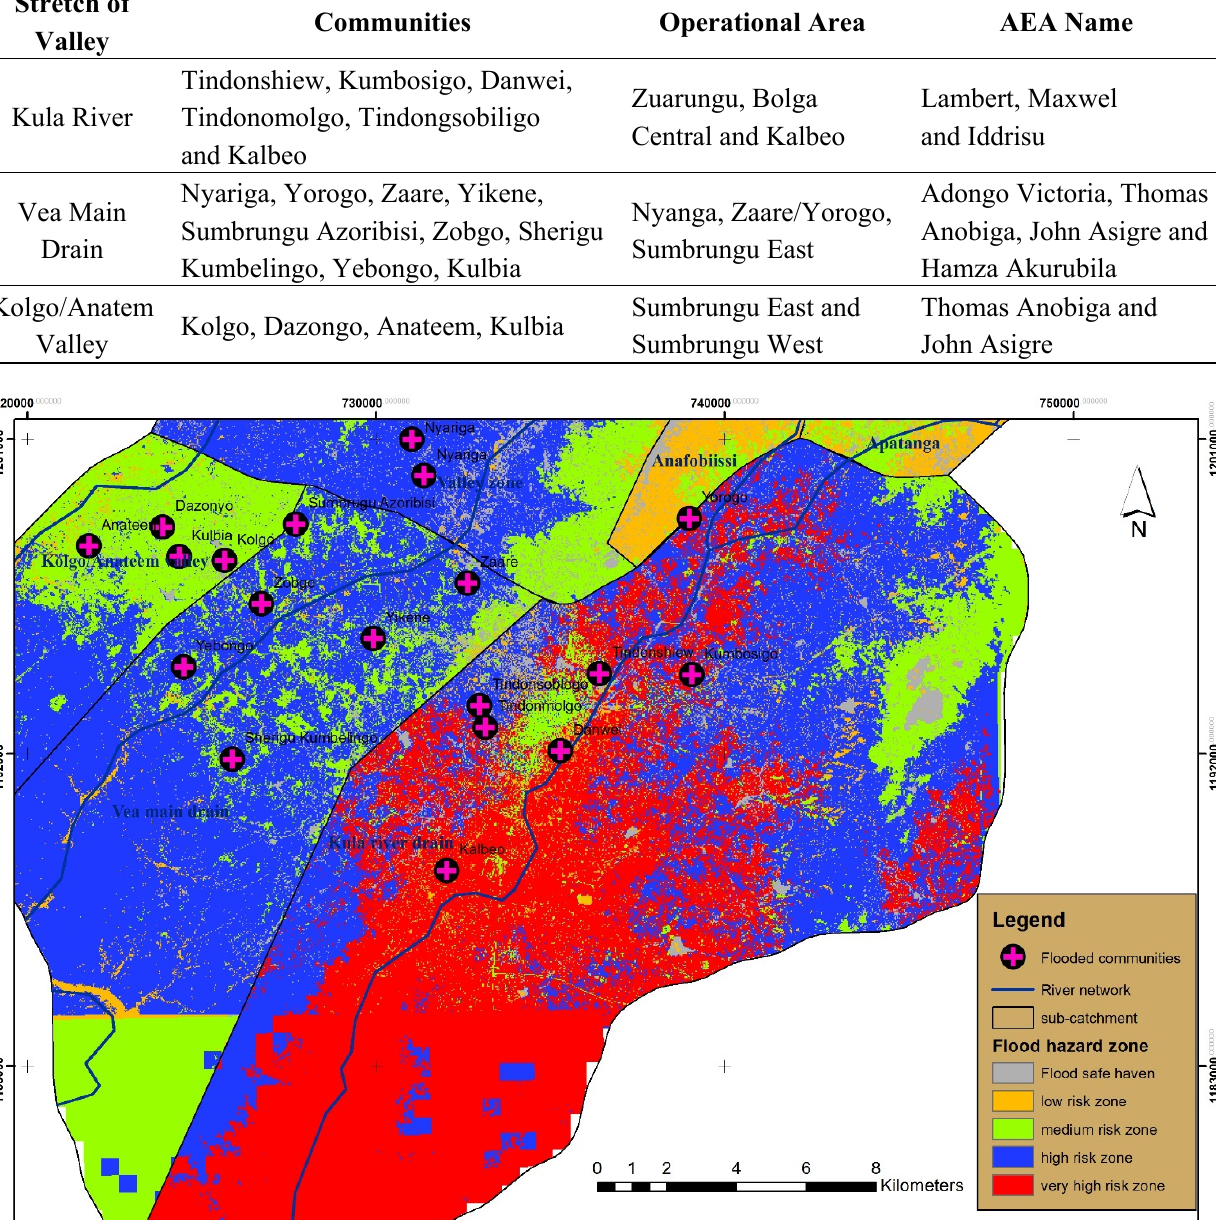
Table 11. List of flood prone communities as listed by local agricultural authority. Source: District MoFA office, Bolgatanga.